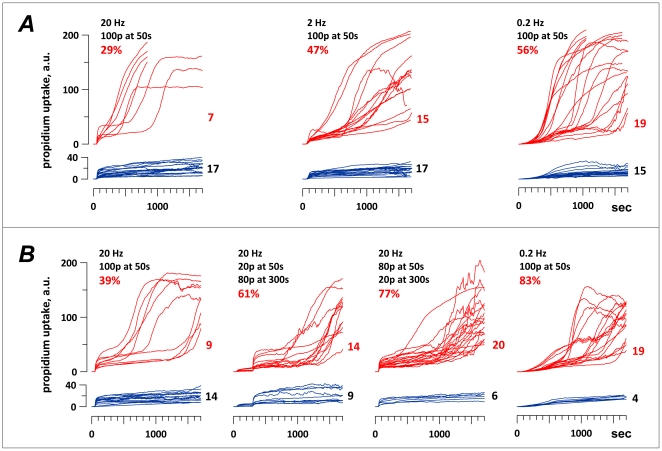
The effect of PRF (A, B) and exposure fractionation (B) on the incidence of delayed membrane rupture in EP-exposed CHO cells.
A and B are two separate and independent series of experiments; within each series, different exposure regimens were alternated in random order. Membrane integrity was probed by Pr uptake; each curve corresponds to Pr uptake in an individual exposed cell, as measured by cell imaging every 10 s throughout the experiment. EP exposure caused transient Pr uptake due to electroporation in all cells and delayed/accelerated Pr uptake due to secondary membrane rupture in some cells (see Fig. 4 and text for more detail). For clarity, for each type of treatment, cells that showed only transient Pr uptake (blue curves, bottom graphs) are separated from cells that showed both transient and delayed Pr uptake (red curves, top graphs). The number of cells that fell into each of the two categories is shown to the right of the graphs. In all groups, cells were exposed to 100, 60-ns pulses at 13.3 kV/cm, whereas the PRF and pulse delivery protocols varied (see legends in the figure). The legends also give the percent of ruptured cells in each group. Note the increase of EP exposure efficiency at lower PRF (A and B) and also when the 20-Hz train was split in two fractions (B). Single-train 20- and 0.2-Hz exposures in A and B are identical treatments, although in B both showed somewhat higher efficiency.